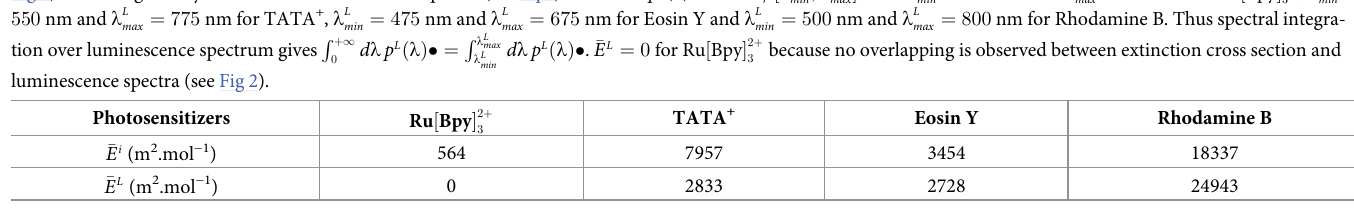
; l L � , with l L ¼ 500 nm and l L ¼ 800 nm for Ru ½ Bpy � 2 þ , l L ¼ 3 min max min max min ¼ 500 nm and l L ¼ 800 nm for Rhodamine B. Thus spectral min max